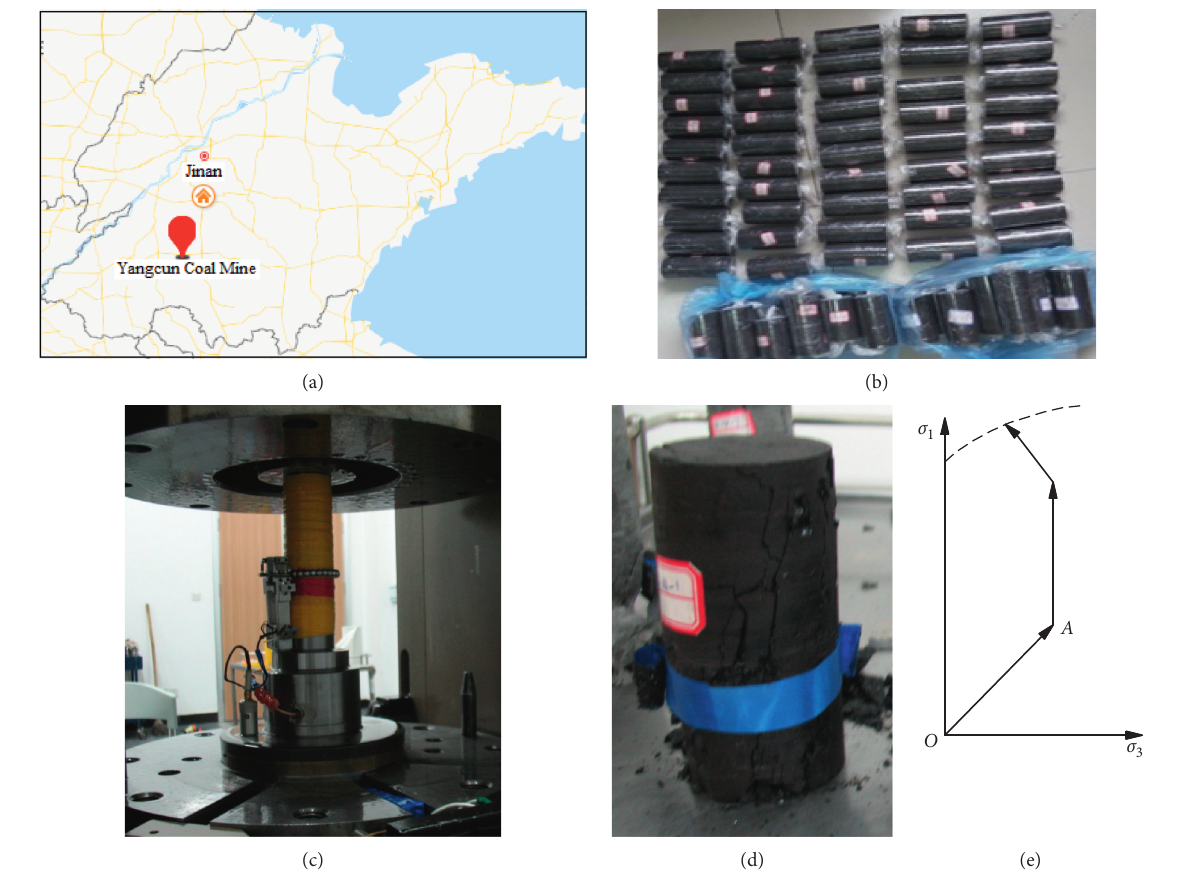
Figure 1: Testing apparatus and rock samples after testing.